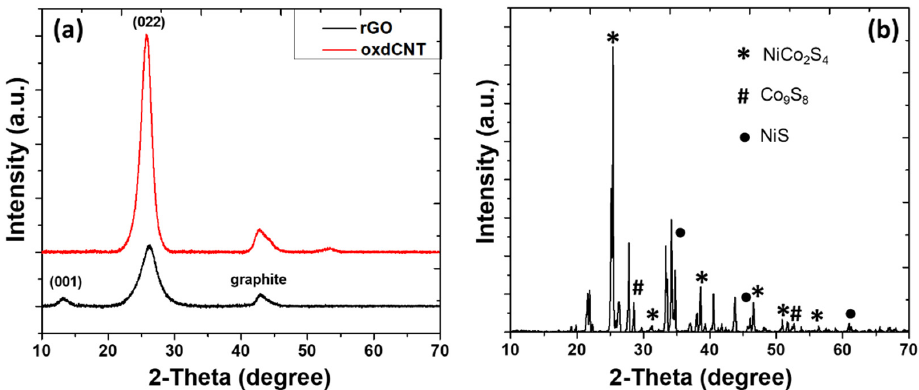
Figure 4. XRD pattern of the rGO and oxdCNT ( a ) and (NiCo)–S@rGO/oxdCNT powders ( b ).